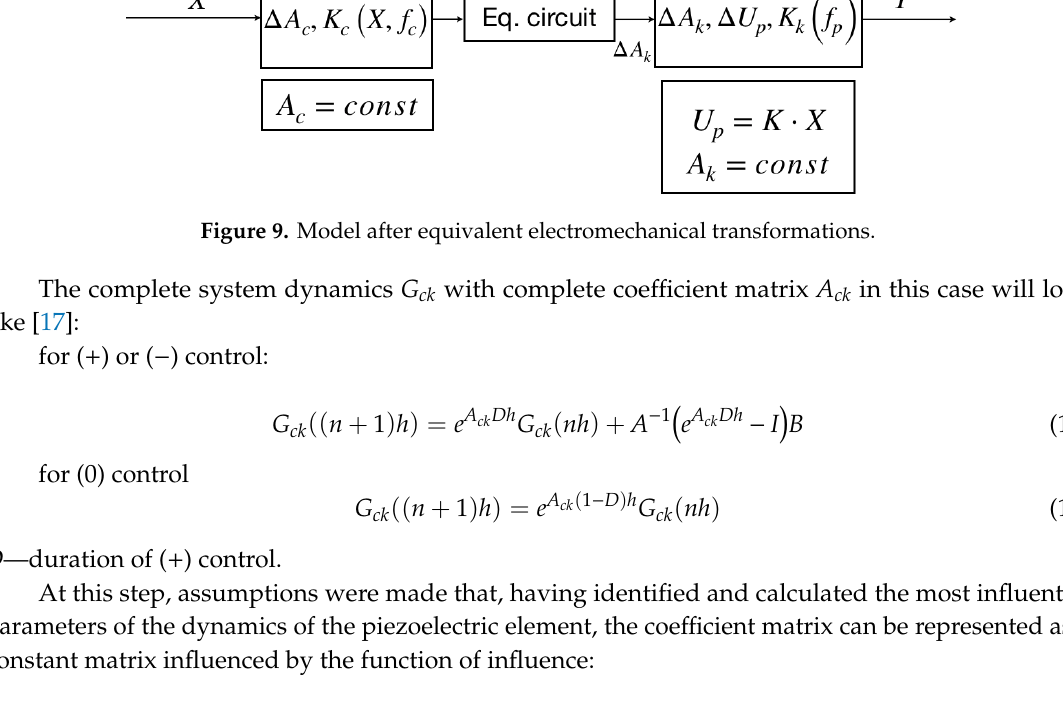
Figure 11. Calculation of calculation on frequency constancy intervals on the frequency constancy intervals.